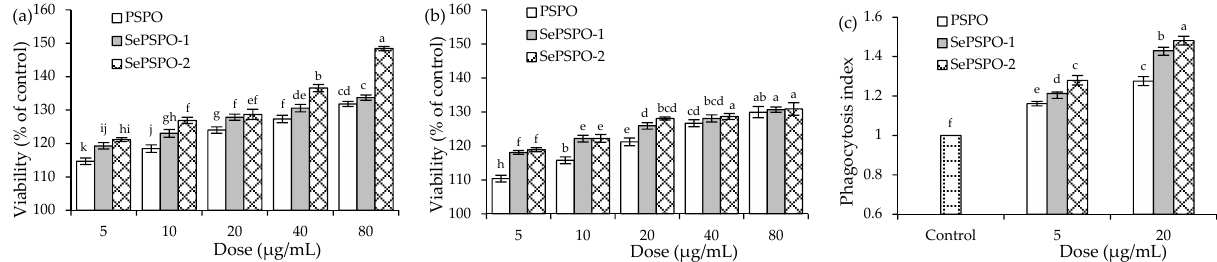
Figure 1. The measured cell viability values (%) of the macrophages exposed to PSPO, SePSPO-1, and SePSPO-2 for 24 ( a ) and 48 h ( b ), as well as the phagocytosis ( c ) of the macrophages exposed to PSPO, SePSPO-1, and SePSPO-2 for 24 h. Different letters lowercase above the columns suggest that the one-way ANOVA of the mean values is significantly different ( p < 0.05).